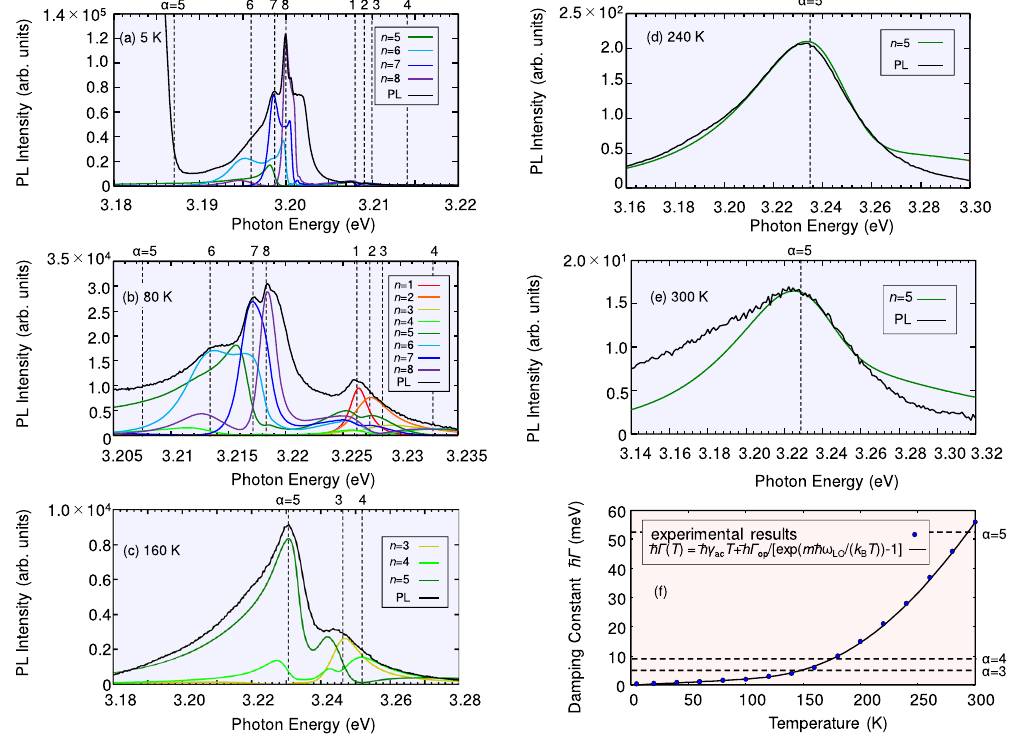
Figure 2. Measured PL spectra (black solid lines) at ( a ) 5 K, ( b ) 80 K, ( c ) 160 K, ( d ) 240 K, and ( e ) 300 K for a CuCl thin film with a thickness of 318 nm. Coloured solid lines show the spectra of the induced polarization associated with respective n th confined excitons. ( f ) Temperature dependence of the damping constant ℏ Γ . Blue dots represent the values determined by the fitting, and the black solid line is derived from the equation ℏ Γ ( T ) = ℏ γ ac T + ℏ Γ op /[exp[ mℏΩ LO /( k B T )] − 1]( m ∈ 